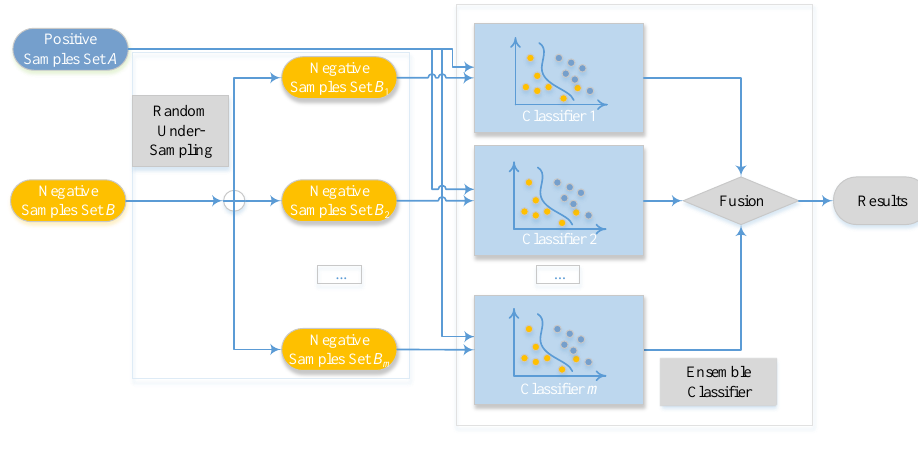
Figure 2. Overview of the ensemble